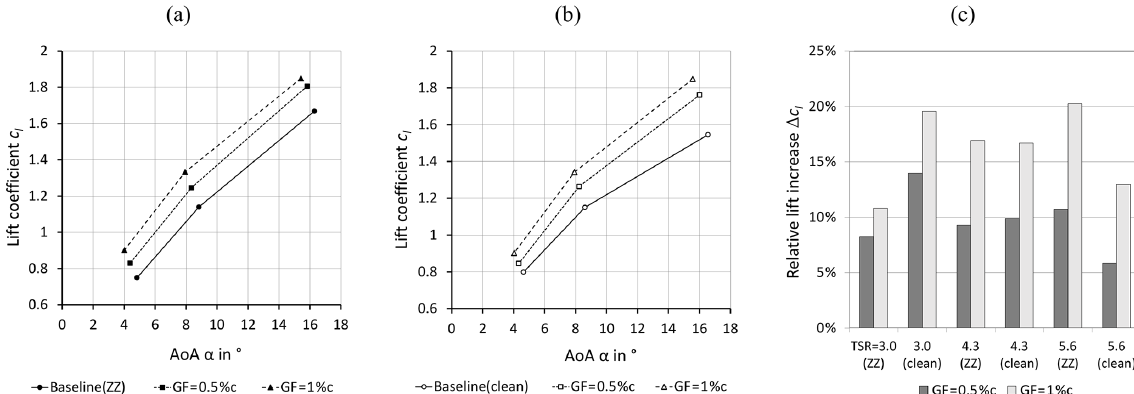
Figure 10. Lift coefficients over angles of attack at r = 0.45 R and ϕ = 270 ◦ . (a) Tripped case. (b) Clean case. (c) Relative lift increase in Gurney flap configurations in relation to the corresponding baseline.